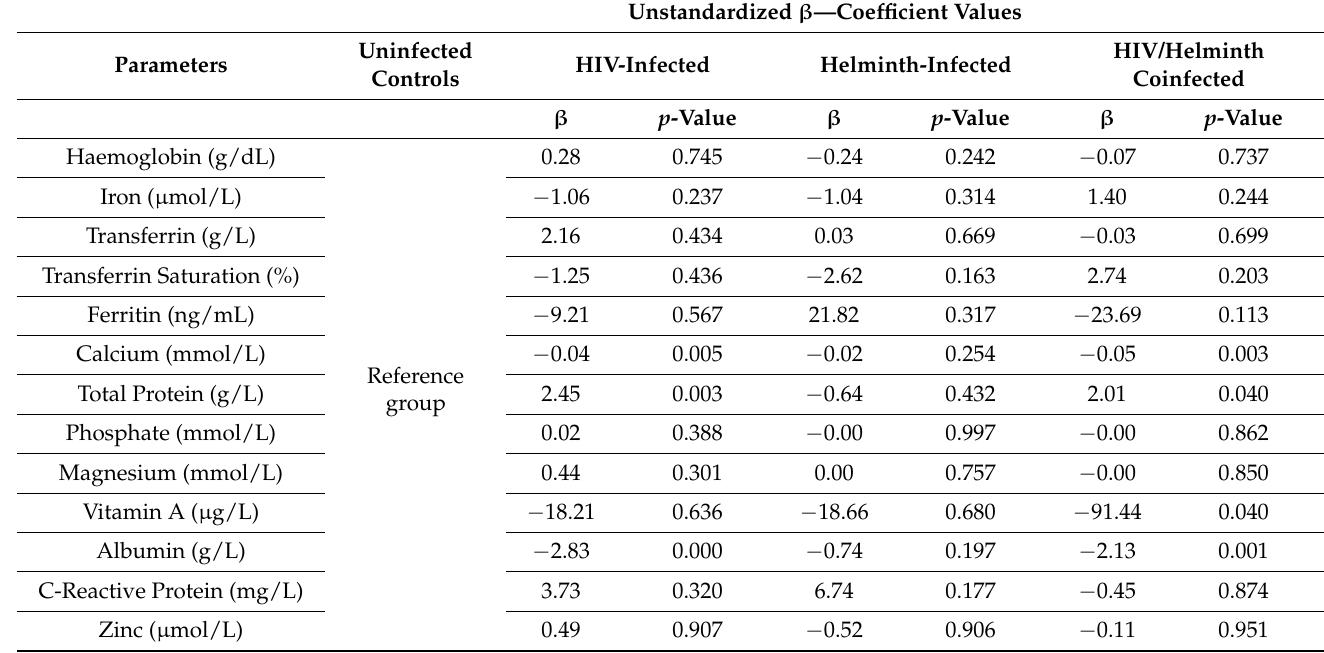
Table 3. Multivariate association of micro- and macro-nutrients and haemoglobin levels with HIV and helminth singly infected, coinfected and uninfected control